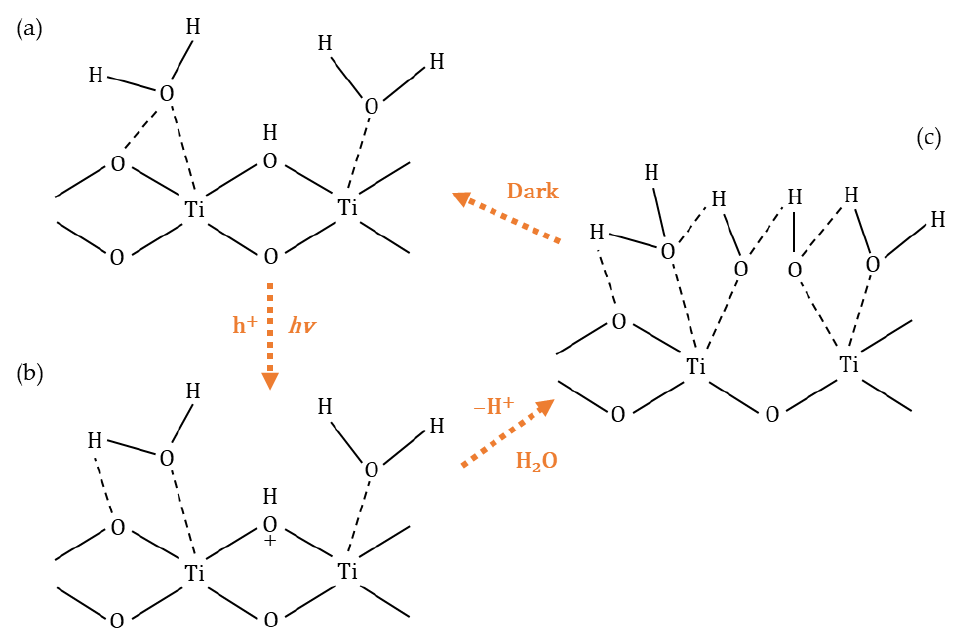
Figure 5. Surface reconstruction on TiO 2 during the reversible hydrophilic changes: ( a ) before UV irradiation OH group is bound to oxygen vacancy; ( b ) at the transition state, where the photogen- erated hole is trapped at the lattice oxygen; and ( c ) after UV irradiation, when new OH groups were formed.